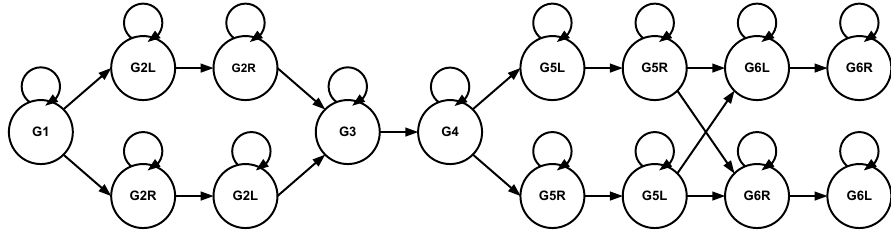
Figure 2. A hidden Markov model (HMM) chain representing the WHO hand washing